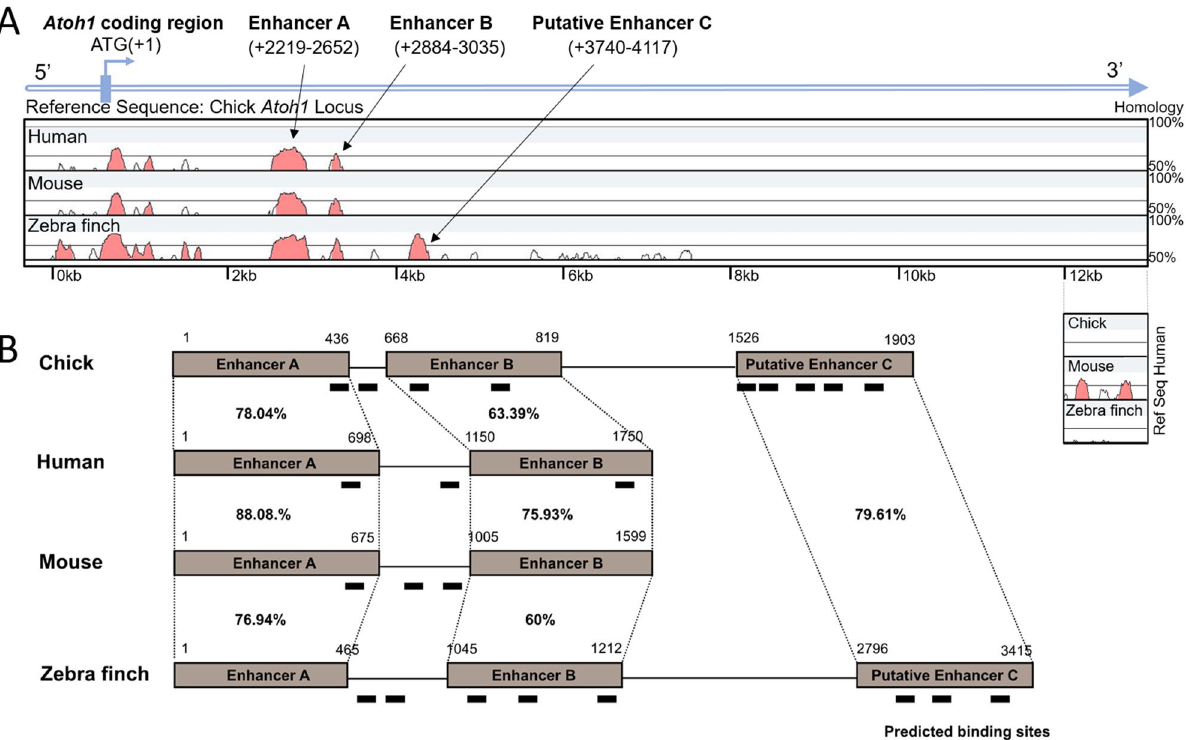
Figure 1. Alignment between the chick, human, mouse and zebra finch Atoh1 genomic sequences. ( A ) The chick Atoh1 sequence was used as the basis for comparison and conserved regions are highlighted in pink. Conservation levels are represented in the y axis (in percentages) and the length of the conserved regions is presented in the x axis (minimum length 100 bp). The diagram exported from mVista 27 shows that some regions within the Atoh1 coding sequence are highly conserved among chick, human, mouse and zebra finch ( Atoh1 coding sequences correspond to chromosome 6:64729125-64731245 in mouse, chromosome 4:93828753- 93830964 in human and chromosome 4: 36493650-36494082 in chick; forward strand, all Ensembl release 91, accessed –December 2017). The two highly conserved regions previously characterized by Helms et al. 2000 24 and Ebert et al., 2003 28 and defined as the Atoh1 enhancer A and B are also conserved among the four species including zebra finch. An additional non-coding region (annotated as putative enhancer C; genomic location 4:37326061-37326437, release 91, updated to 4:37047224-37047600 in latest Ensembl release 102, November 2020; see Supplementary Figure S1 for sequence) shows a high degree of homology between chick and zebra finch but does not share homology with the 3’ region of the mouse and human Atoh1 . During revision of this Atoh1 genes; its position is shown below the main alignment using the human sequence as the reference. ( B ) Schematic representation (not to scale) of the position of Atoh1 enhancers A, B and putative